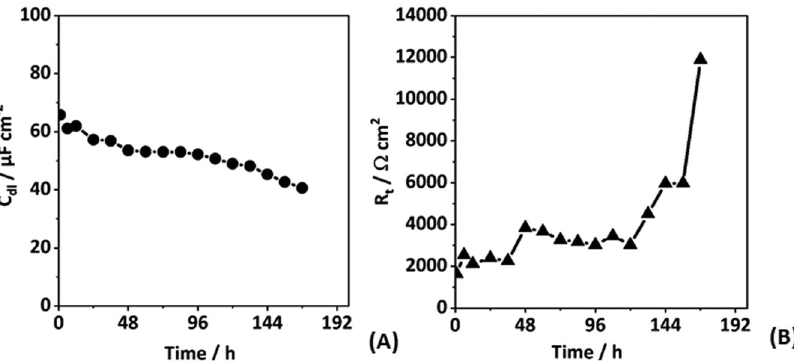
Fig. 11 EEC model parameters evolution during the 7 days of continuous cathodic polarization. Double-layer capacitance (Cdl) estimated with the Brug law ’ s in ( A ) and a charge transfer resistance (Rt) in ( B ) in function of time and estimated from EIS data measured with EC-LAB ® software modelling, in static conditions, natural aeration, and 20 °C.